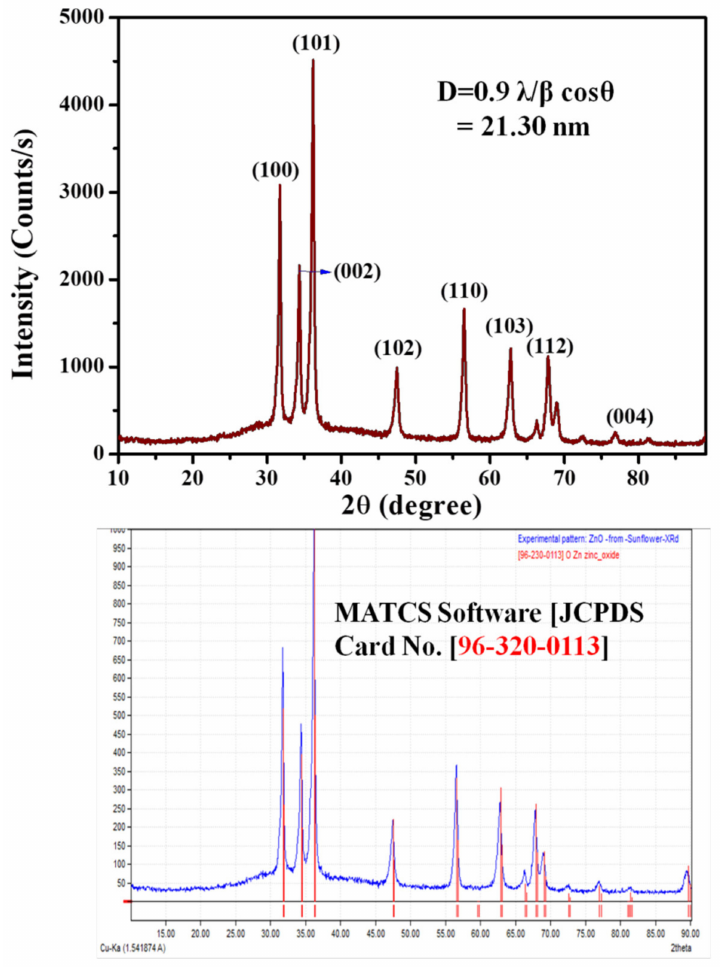
Figure 5. The synthesized ZnO NPs of XRD and standard JCPDS XRD data.